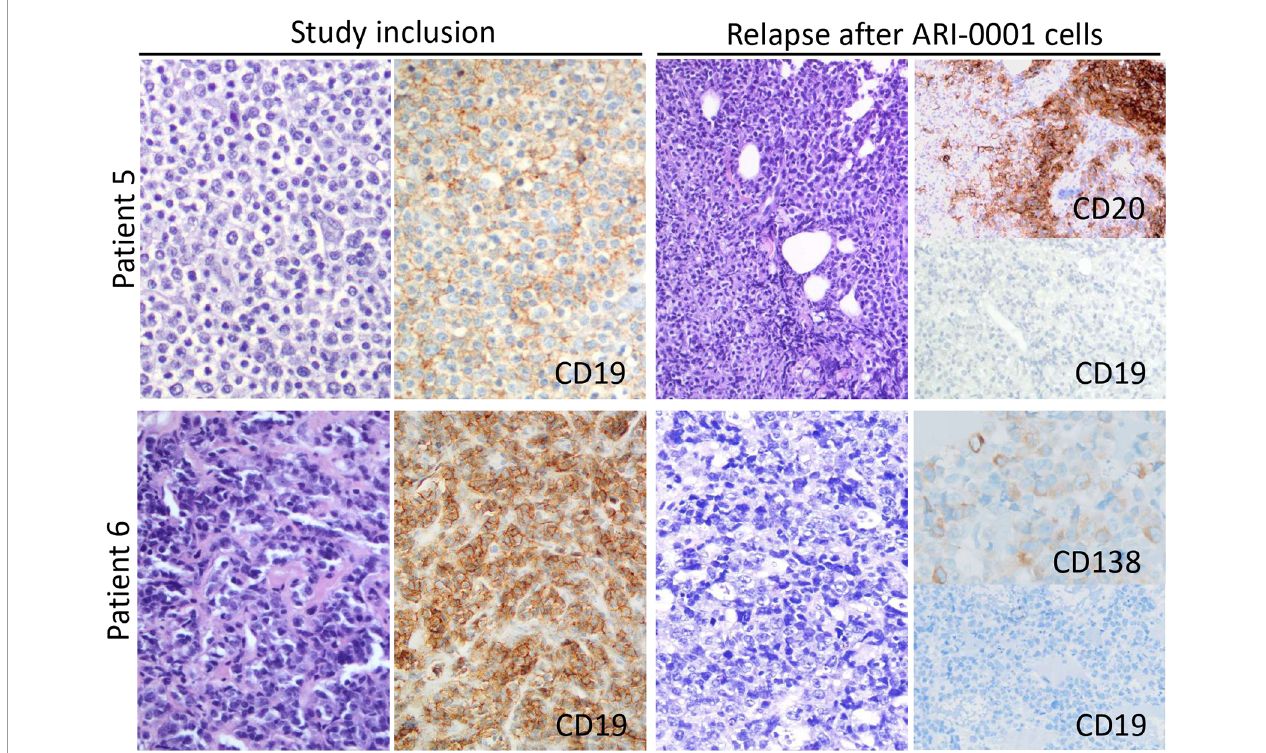
FIGURE 3 | Lymph node morphology and phenotype observed in patients 5 and 6 at both study inclusion and relapse after treatment with ibrutinib-primed ARI- 0001 cells. In both cases, CD19 expression was lost upon